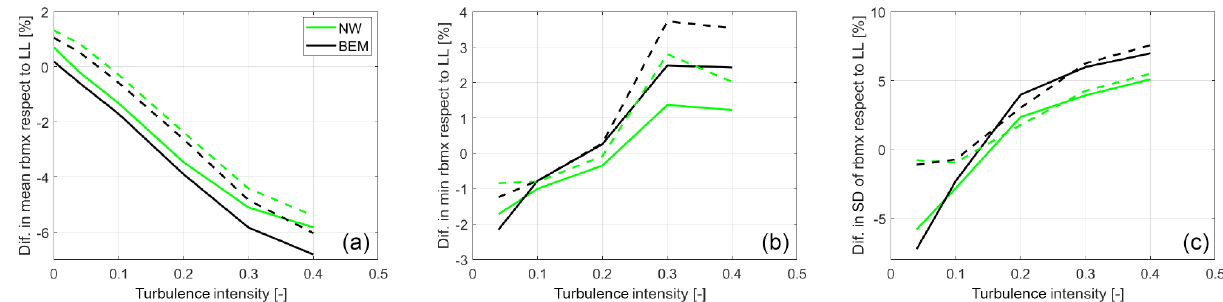
Figure 15. Differences in flapwise root bending moment in the function of turbulence intensity (a) mean, (b) minimum, and (c) standard deviation. Solid lines represent the baseline blade, while dashed lines represent the optimized tip design.